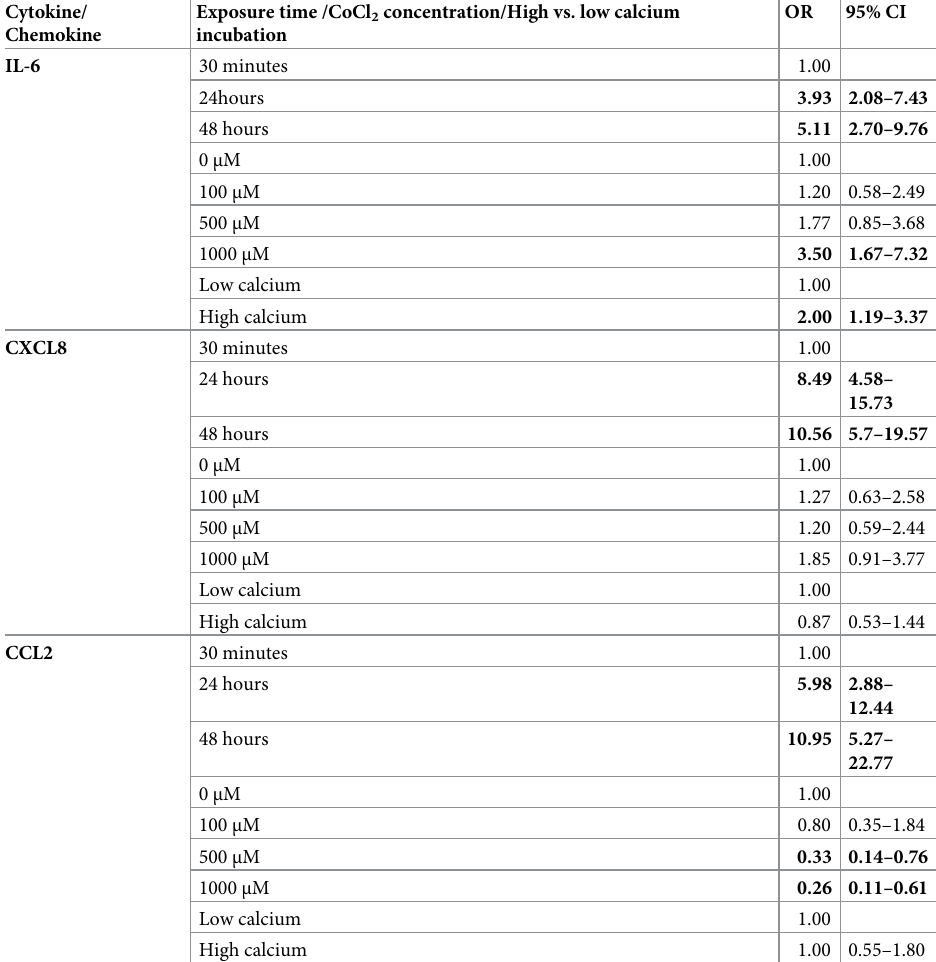
Table 2. Linear regression mixed model analyses for dose- and time-trends for IL-6, CXCL8 and CCL 2 secretion (relative expression) from HaCaT cells. Cytokine/